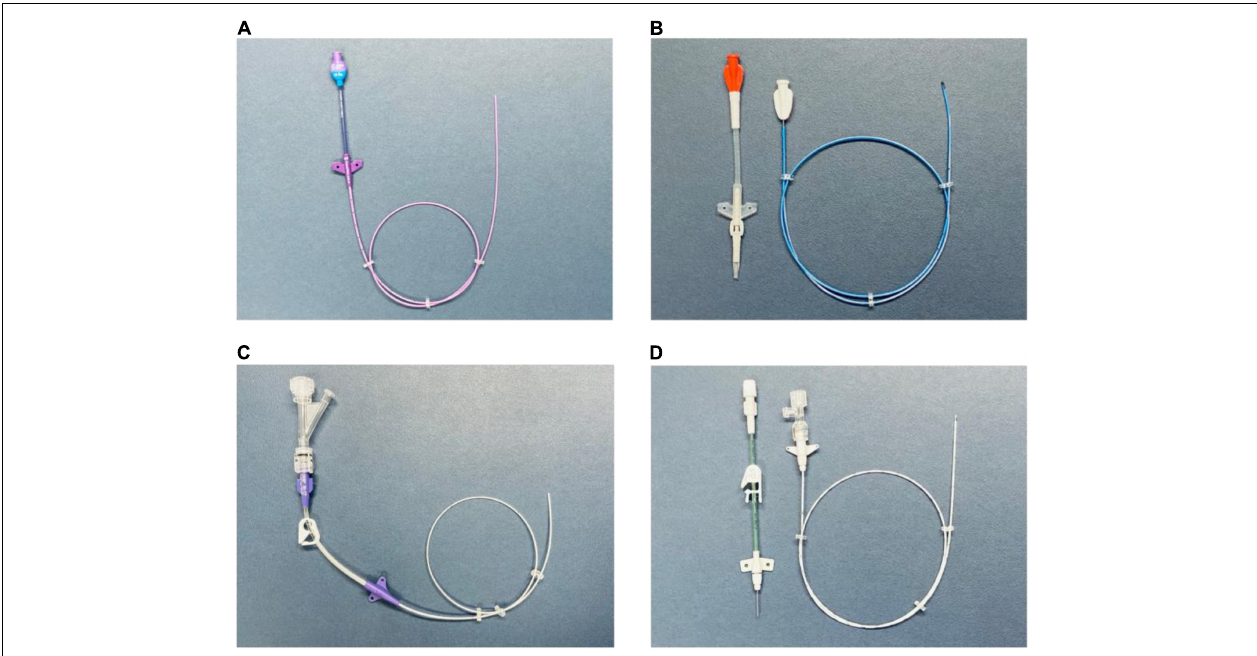
FIGURE 2 | (A) PICC with a free-end-side trim point (technique A). Valved reverse-tapered device with solid-wire signal conduction. PUR material with high-flow injection properties. (B) PICC with a hub-side (outer part) trim point (technique B). Centrally valved straight device with solid-wire signal conduction and silicone material without high-flow injection properties. (C) PICC with a free-end-side trim point (technique A). Non-valved reverse-tapered device with liquid (saline) signal conduction. PUR material with high-flow injection properties. (D) PICC with a hub-side (outer part) trim point (technique B). Non-valved straight device with liquid (saline) signal conduction. PUR material with high-flow injection properties. PICC, peripherally inserted central catheter; PUR,